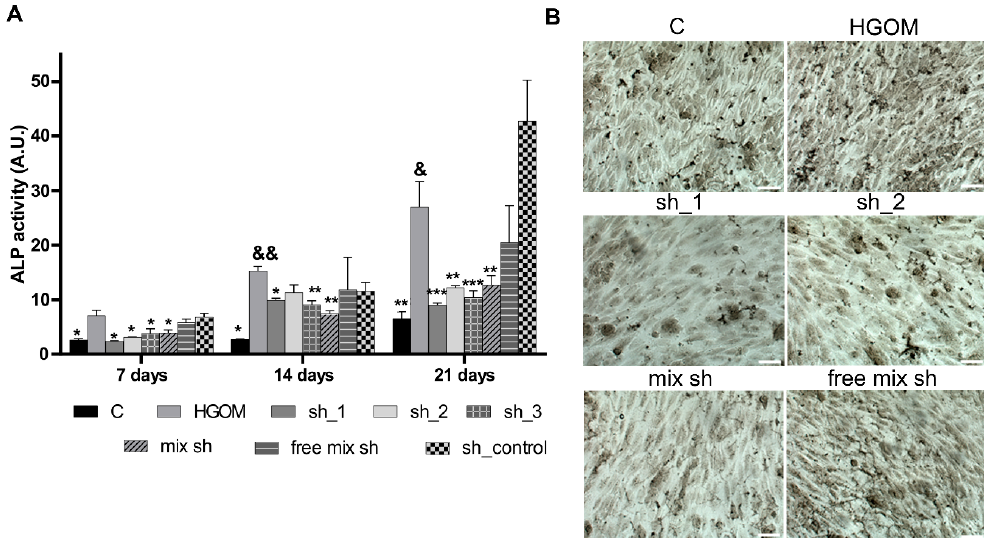
Figure 5. Down-regulation of Runx2 expression using C60-PEI/shRNA-Runx2 plasmids inhibits ALP activity in VIC exposed to HGOM. Quantitative assay at 7, 14 and 21 days (A) and histochemical detection at 14 days (B) of ALP activity (scale bar 100 µm). Data are presented as mean ± S.D. of two experiments made in three replicates (n=6). *p<0.05, **p<0.01, ***p<0.001 compared to HGOM; &p<0.05, &&p<0.01 versus HGOM at day 7.